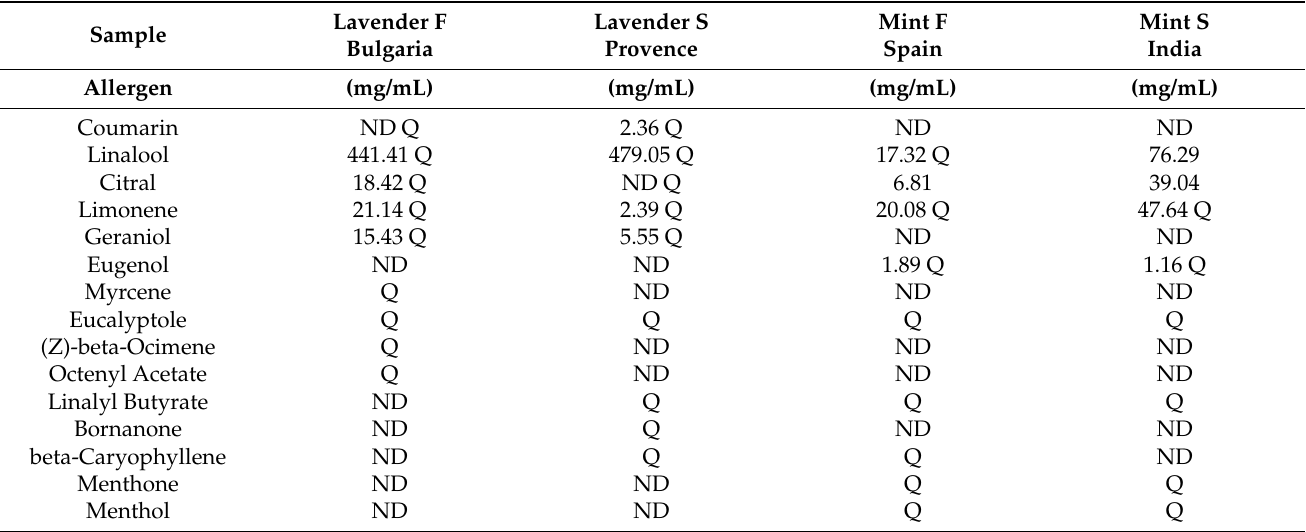
Table 4. Quantitative and qualitative analysis of